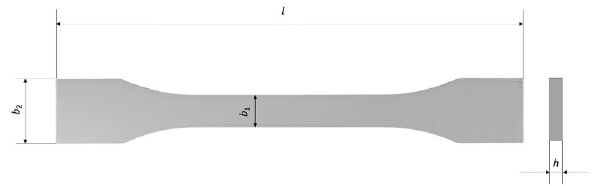
Fig. 5 Tensile test specimen 1B with the relevant dimensions for the later quality control in accordance with Refs. [18–22]